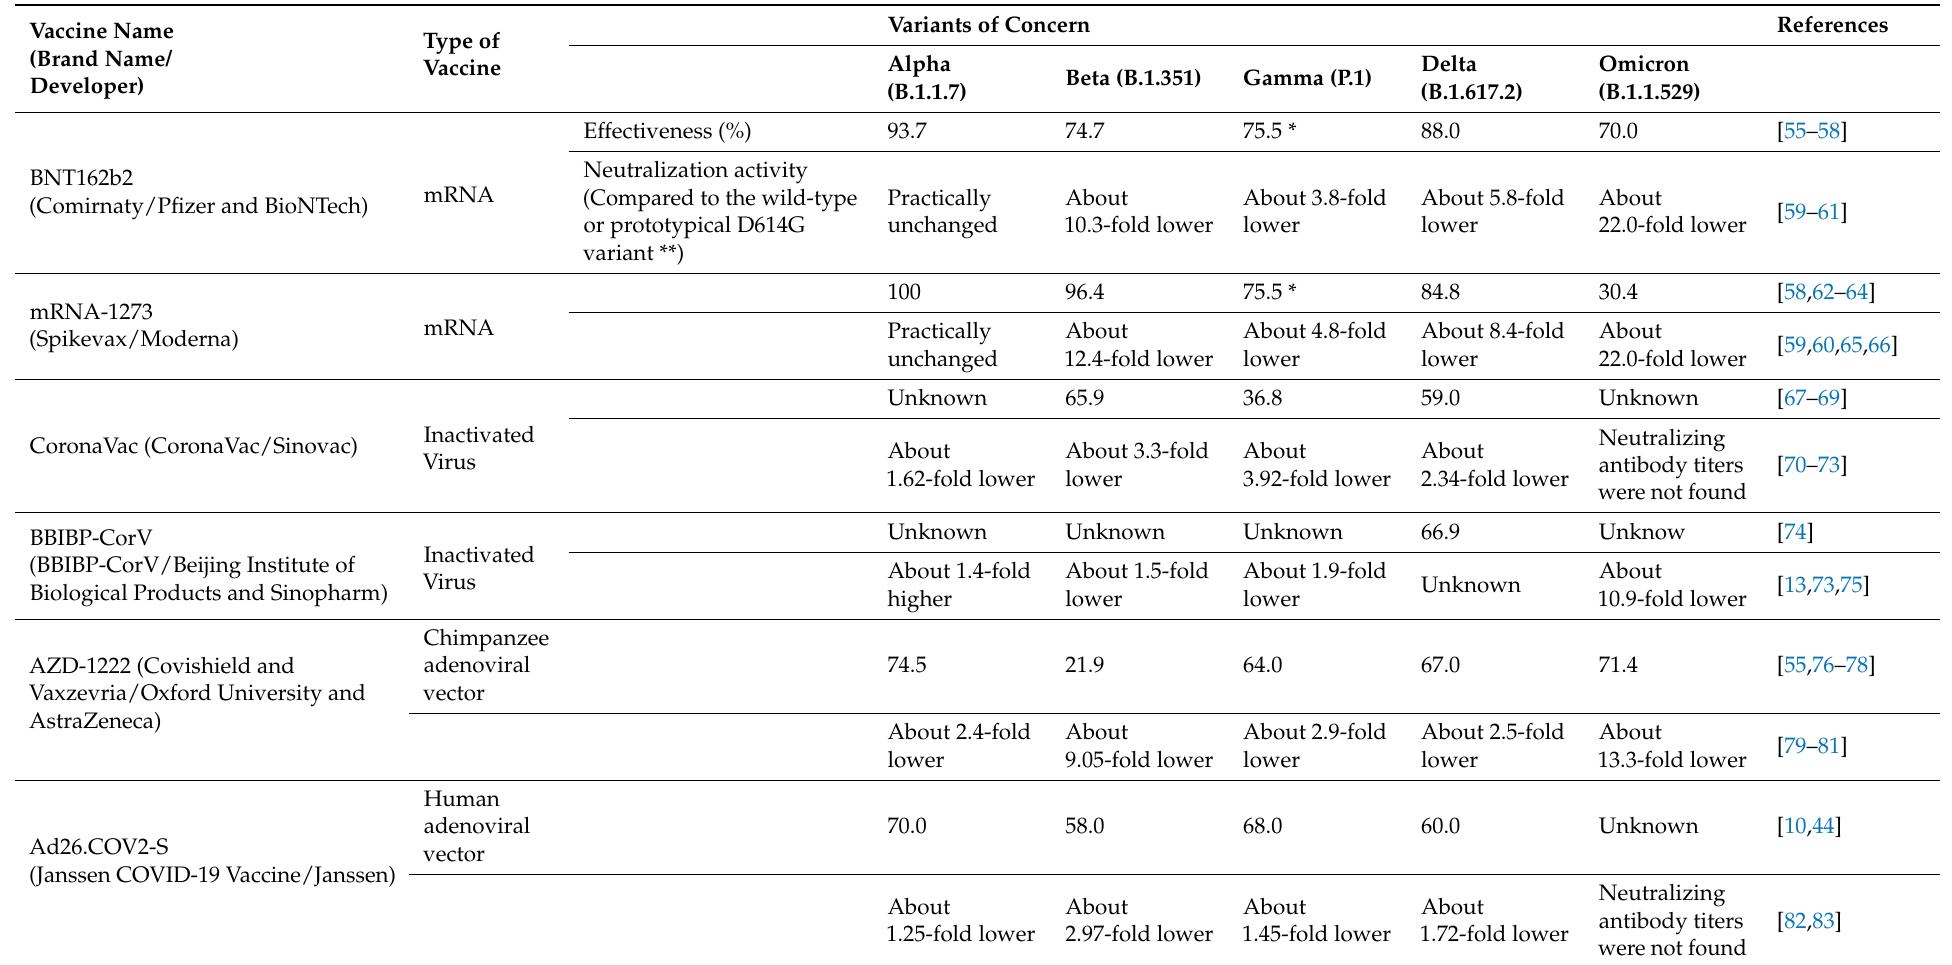
Table 2. Efficiency and neutralization activity of major COVID-19 vaccines against variants of concern after primary